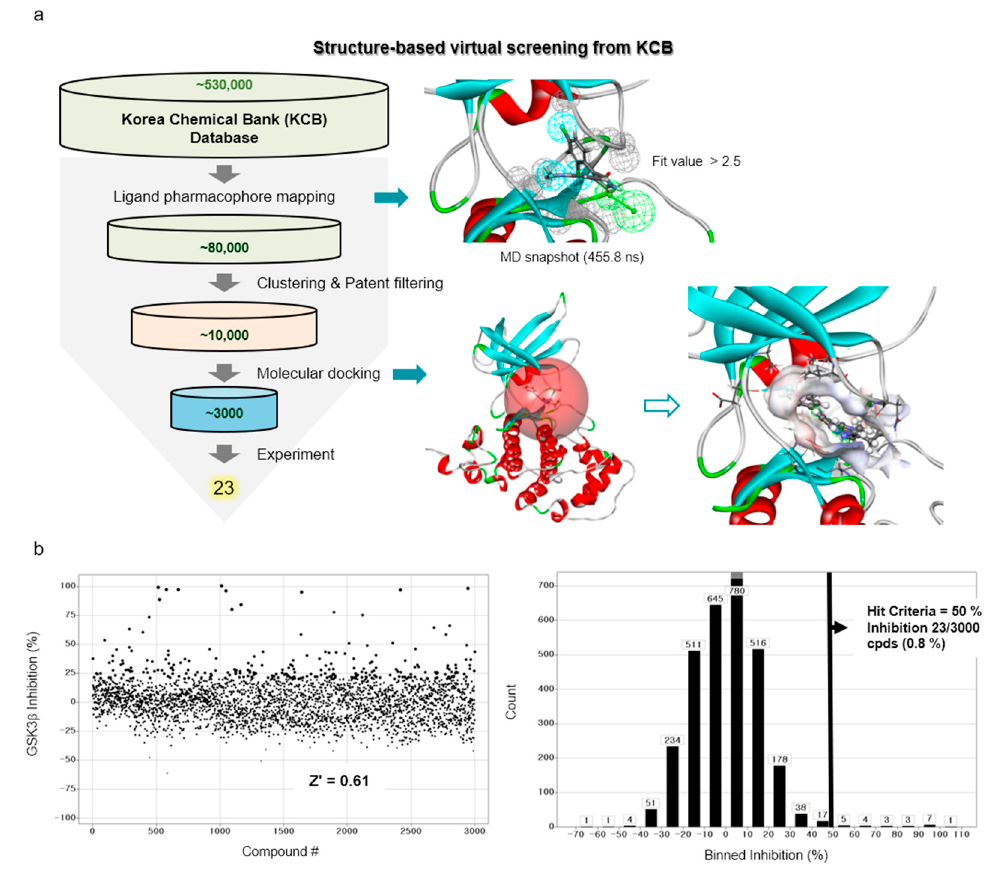
Figure 2. Workflow for the discovery of GSK3 β inhibitors using a structure-based virtual screening protocol, including molecular dynamics and molecular docking simulations. ( a ) The procedure of structure-based virtual screening shows the resulted pharmacophore model from the representative structure (in upper right panel) and the calculated binding site (red sphere) with the hit compound, cpd1, for the example of molecular docking simulation (in lower right panel). ( b ) Activity distribution of high-throughput screening